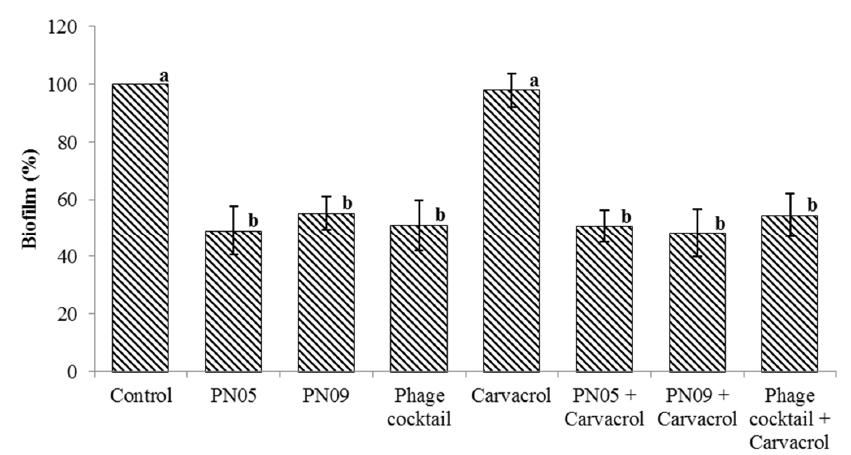
Figure 7. Efficacy of phages and 2.0 mg/mL carvacrol in destruction of 36-h pre-formed Psa (SCJY02-1) biofilm after 24 h. Y-axis means the percentage remaining of pre-formed biofilms. Data are the mean ± standard deviation of three independent assays. Shared letters in the column indicate no statistical di ff erence among groups ( p > 0.05). Di ff erent letters above bars indicate a statistically significant di ff erence ( p <